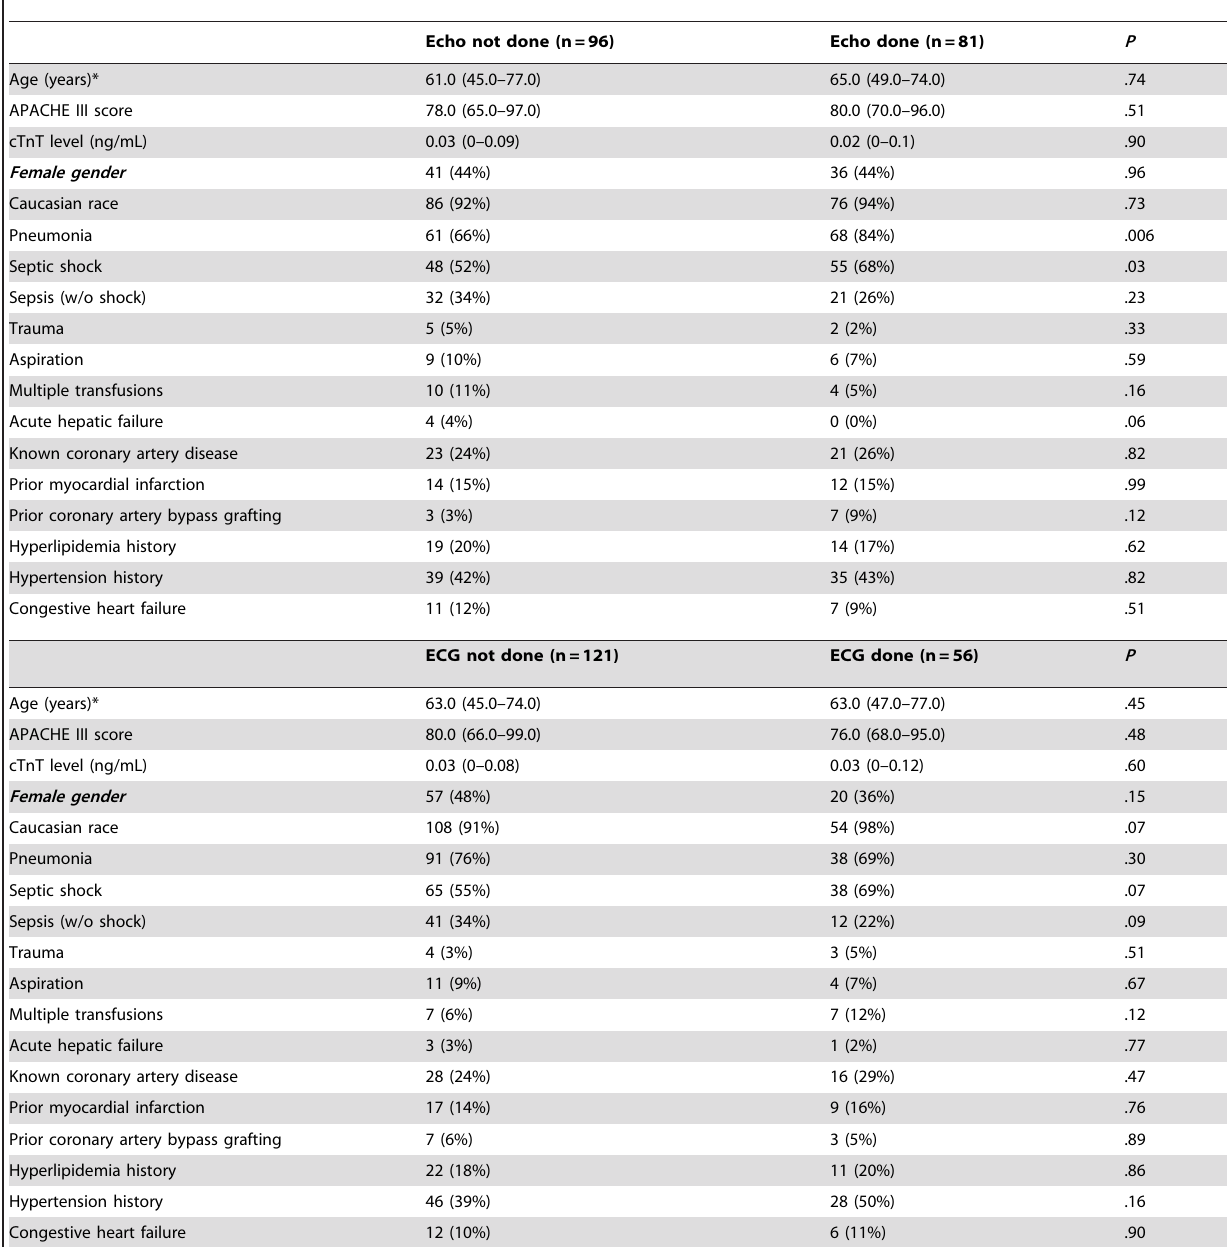
Table 3. Characteristics of patients who received echocardiogram or ECG